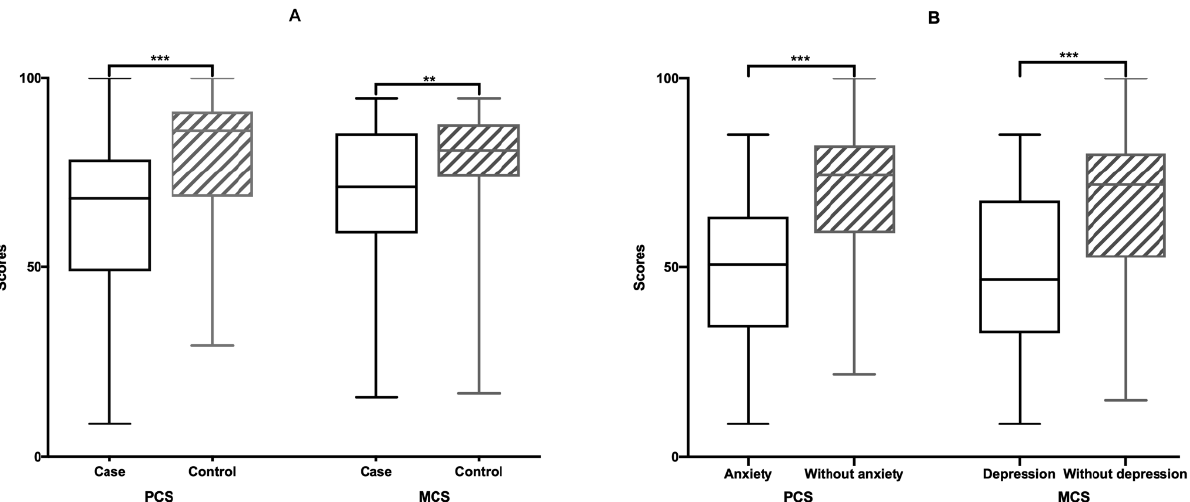
Figure 3. SF-36 ** p < 0.01, *** p < 0.001. ( A ) SF-36 score of patients with adenomyosis and leiomyoma. ( B ) SF-36 score of anxiety and depression in patients with adenomyosis. Table 5. Relationship between anxiety, depression, and quality of life in patients with